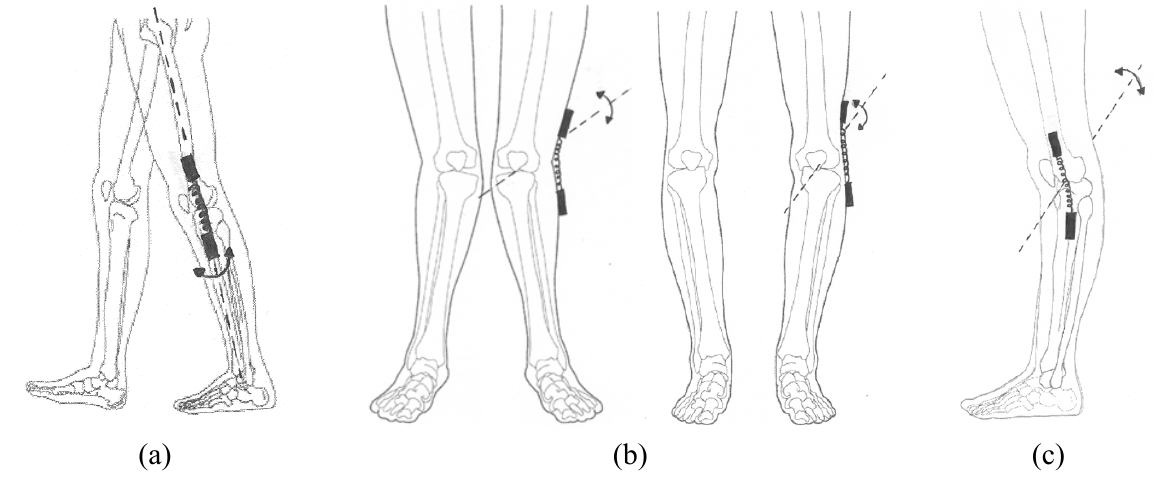
Figure 2. Types of knee endblock misalignments: (a) around the longitudinal axis (in the transverse plane); (b) around the sagittal axis (in the frontal plane); and (c) around the frontal axis (in the sagittal